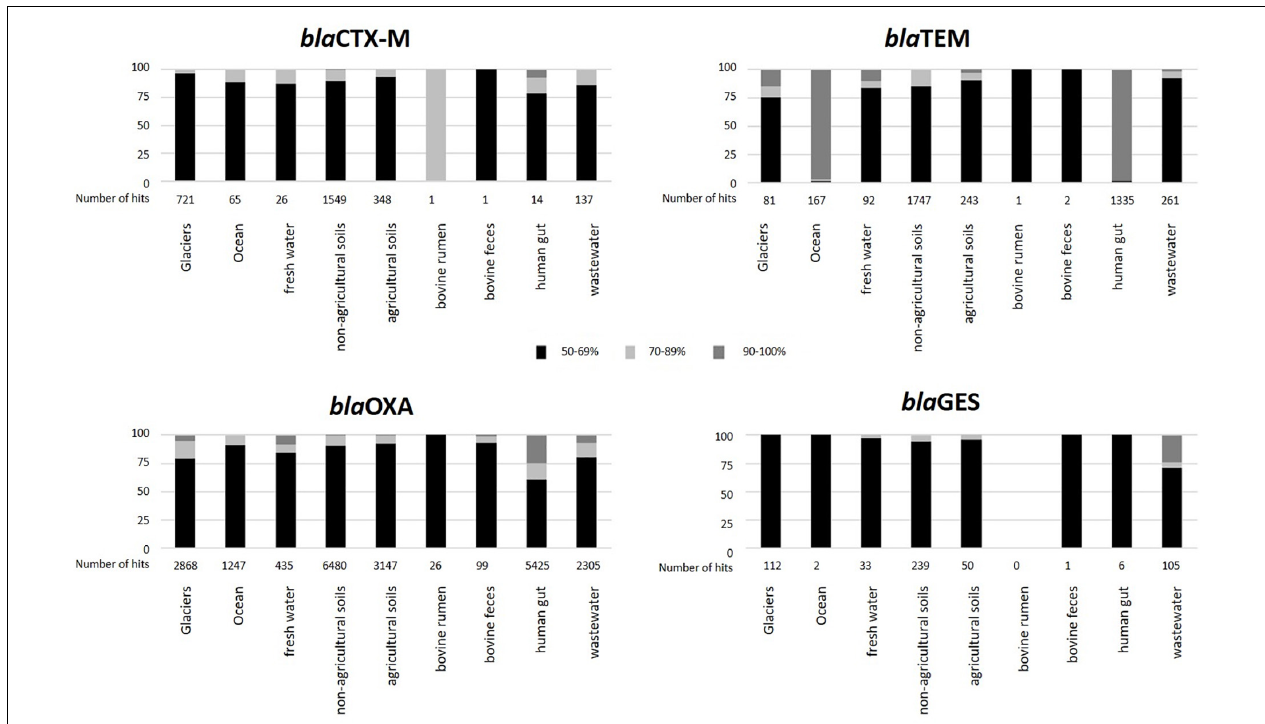
FIGURE 4 | Relative abundance of selected β -lactamases in the targeted environments grouped according to identity (%) to EX-B database sequences. Black: 50–59%; gray: 60–69%; white: 70–79%; white granulated: 80–89%; and black granulated: 90–100%.